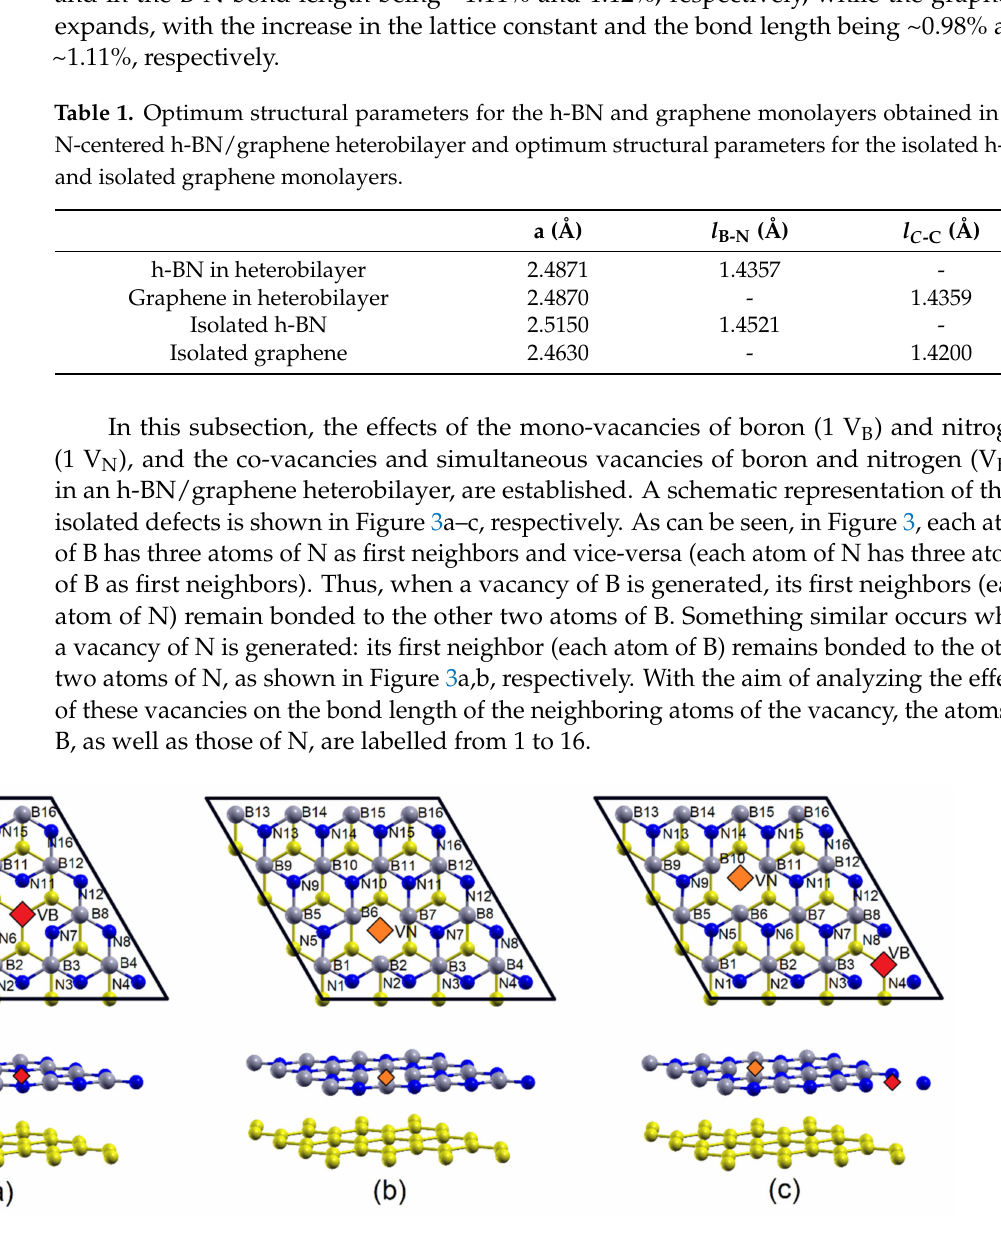
Figure 3. h-BN(4 × 4)/graphene (4 × 4) heterobilayer ( a ) 1 V B , ( b ) 1 V N , and ( c ) V BN ,